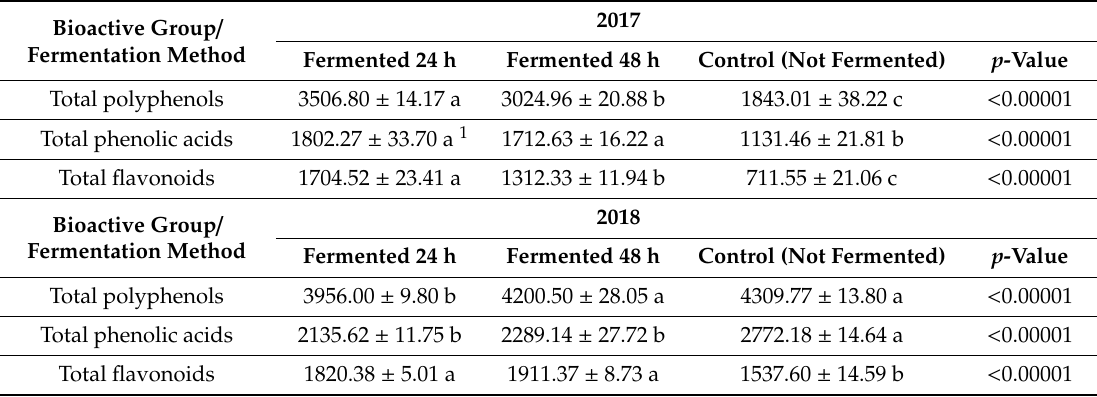
Table 1. The content of the total bioactive compounds (mg 100 g − 1 dry weight (DW)) from di ff erent polyphenols groups in fireweed leaves. Mean value ± standard error, n =